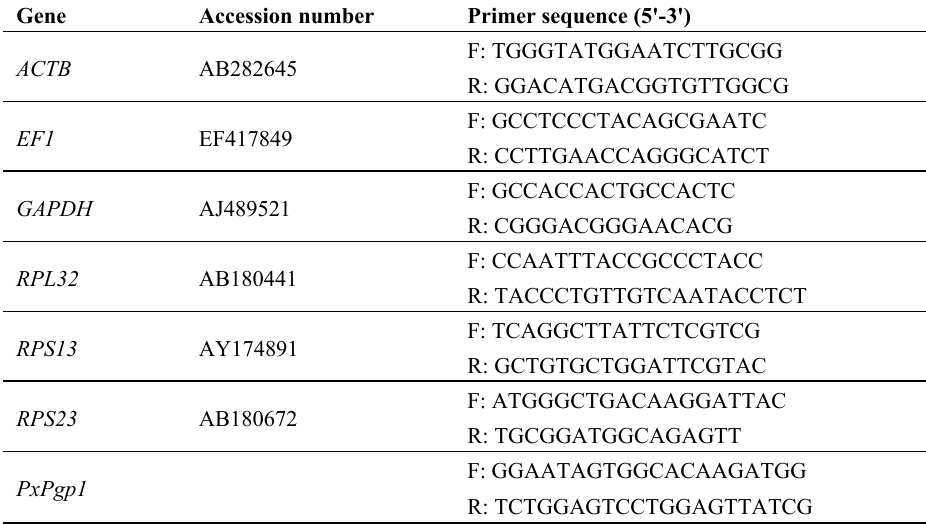
Table 3. Primers used for